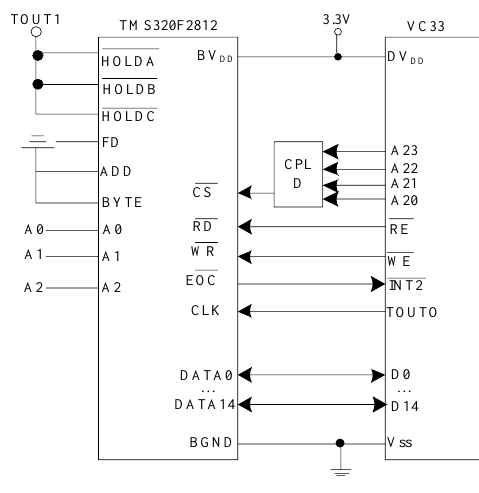
Figure 3. Diagram of DSP and ADC interface circuit After A/D conversion, the conversion end signal EOC is generated and introduced into the interrupt pin of DSP. After each conversion, DSP interrupt is caused, and DSP reads the 16 bit conversion result into internal RAM. The address/mode signals (A0, A1, A2) determine how to read data from ADS8364. Single channel, cycle or FIFO mode can be